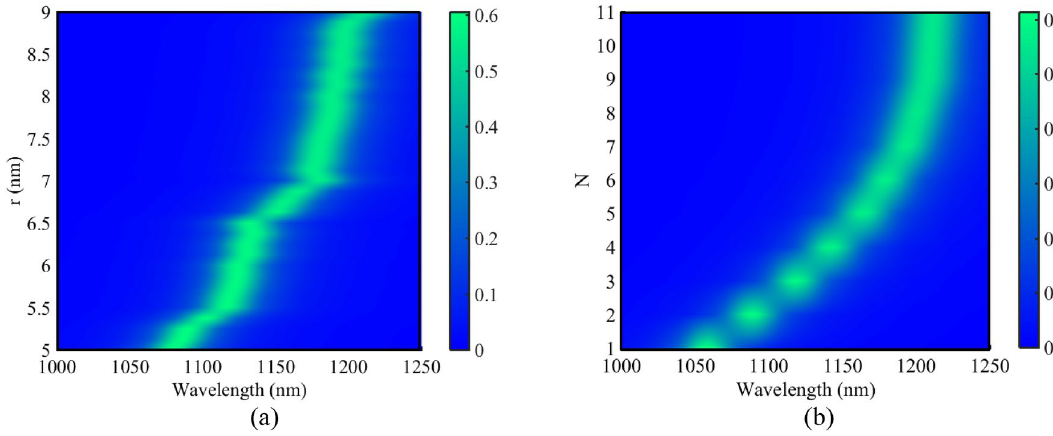
Figure 5. Transmission spectra of Fig. 4a for different values of (a) r, (b)